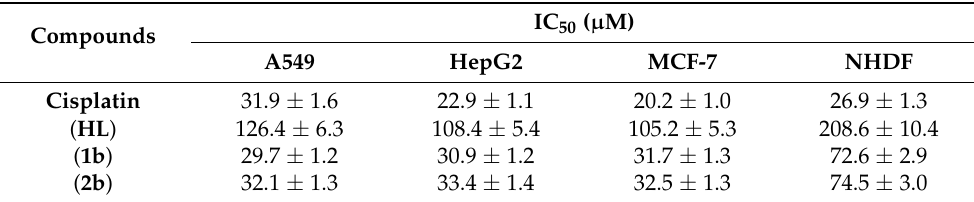
Table 9. The cytotoxicity of ligand ( HL ), mixed ligand complexes ( 1b – 2b ) and standard drug ( cisplatin ) against cancer and normal cell lines.